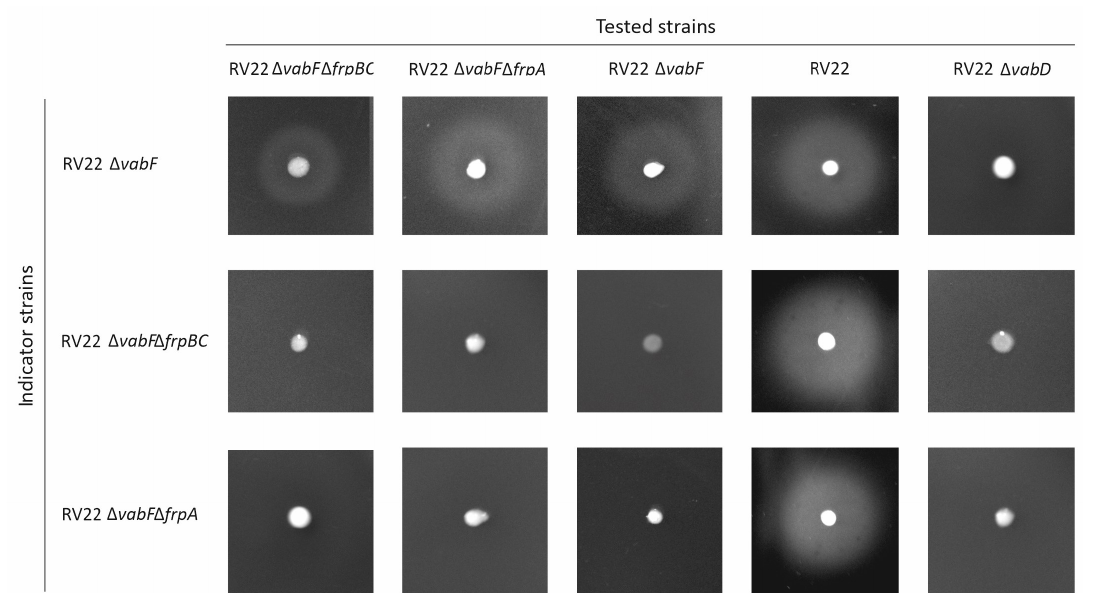
Figure 5. Cross-feeding assay to evaluate piscibactin production by the tested strains (RV22, RV22 Δ vabD , RV22 Δ vabF , RV22 Δ vabF Δ frpBC and RV22 Δ vabF Δ frpA ) and its use by the indicator strains (RV22 Δ vabF , RV22 Δ vabF Δ frpA and RV22 Δ vabF Δ frpBC ). A growth halo of the indicator strains (RV22 ∆ vabF , RV22 ∆ vabF ∆ frpA and RV22 ∆ vabF ∆ frpBC ). A growth halo of the indicator